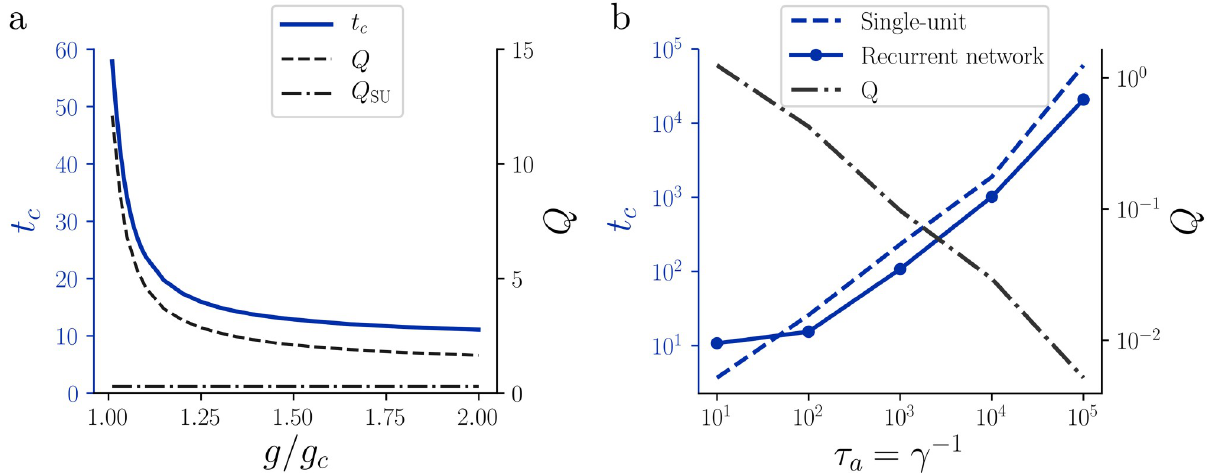
Fig 3. Correlation time and effect of recurrent connections. a: Correlation time (blue solid line) and Q-factor (dashed line) as a function of the ( γ , β ). Adaptation parameters: γ = 0.1 and β = 1. The dash-dotted horizontal connectivity strength. The weakest connectivity level plotted is g = 1.01 g c line indicates the Q-factor of a single unit with the same adaptation parameters, driven by white noise. b: Correlation time (blue) and Q-factor (black, − 1 . Both the recurrent network (solid line) and the single unit driven by white noise dash-dotted line) as a function of the adaptation timescale τ a ≔ γ (dashed line) scale with τ a . β = 1 and g = 1.5 g c ( γ , β